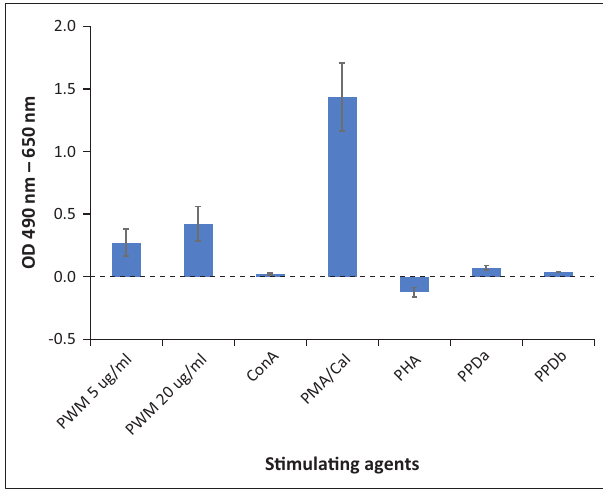
FIGURE 1: Optical densities of plasmas from nyala whole blood samples stimulated with different mitogens and antigens. Average blanked optical density values (490 nm – 690 nm) of mitogen or antigen-stimulated samples. Values were corrected by subtracting the antigen or mitogen values with the negative sample values of respective animals. Error bars represent standard error of the